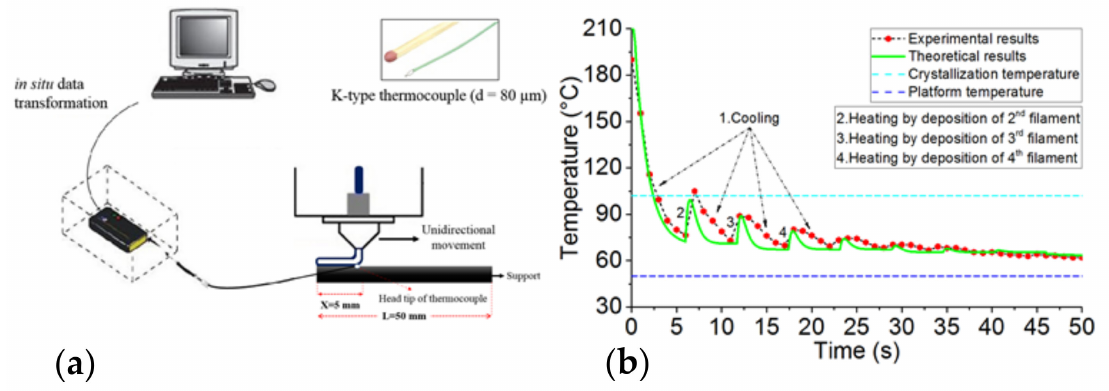
Figure 13. ( a ) Schematic representation of the proposed set-up and ( b ) the experimental–numerical temperature distribution (reprinted with permission from [126]).